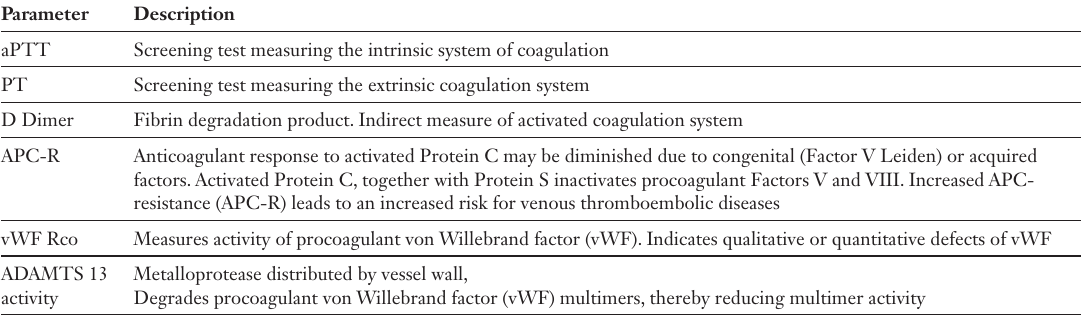
Overview of the investigated coagulation